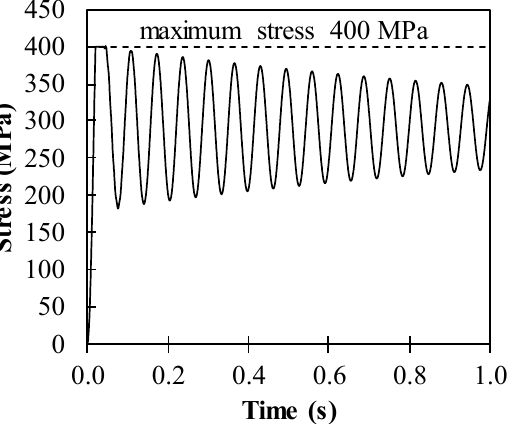
Figure 5. Stress development in steel of the hybrid system containing 8.4 mm thick steel slab and 8.0 mm thick ϕ 100 mm CFRP frame.